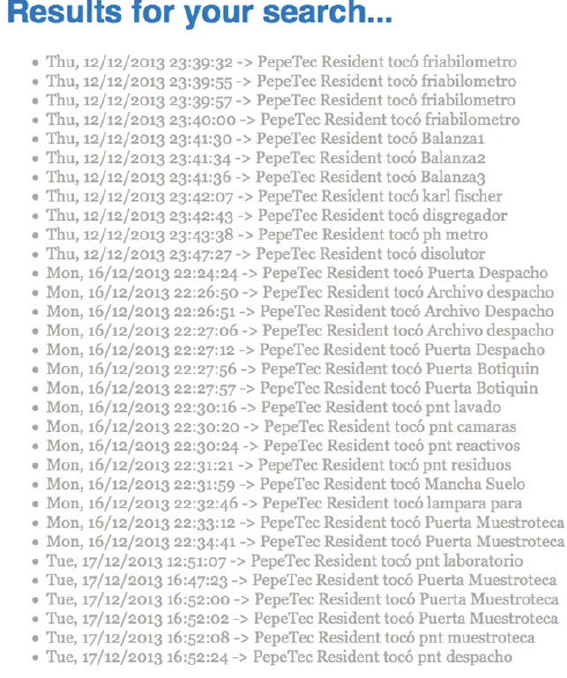
Figure 6: Results for user